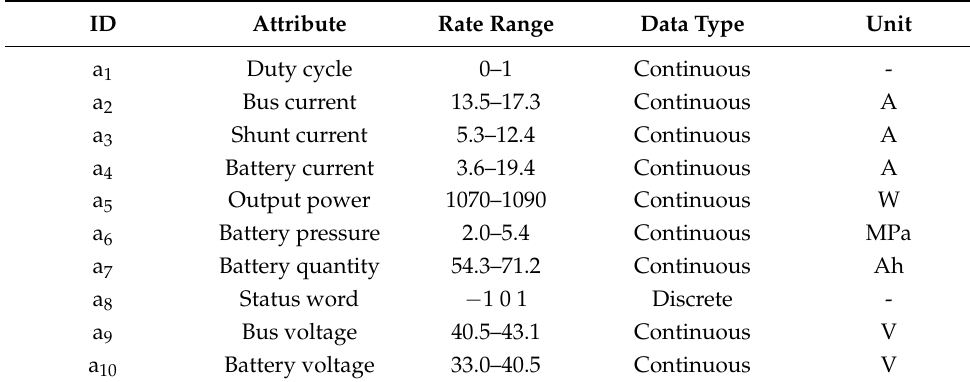
Figure 4. The schematic diagram of the power system. Table 7. Information of the telemetry